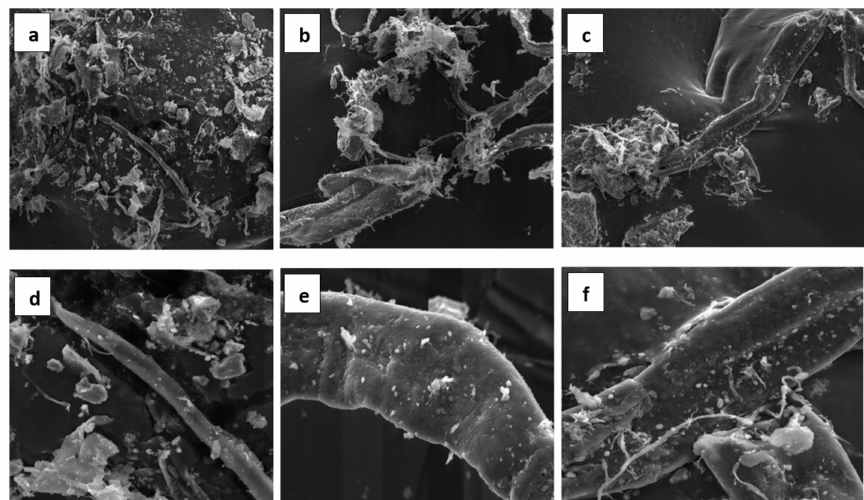
Figure 1. SEM micrographs of WPF samples ( a , d ) A, ( b , e ) B, and ( c , f ) C at magnifications of 1500 × and 6000 × .